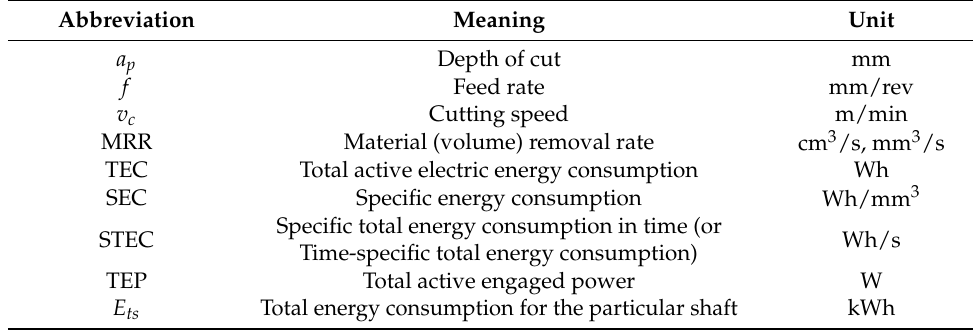
Table 2. Abbreviations, meanings and units of values used in the